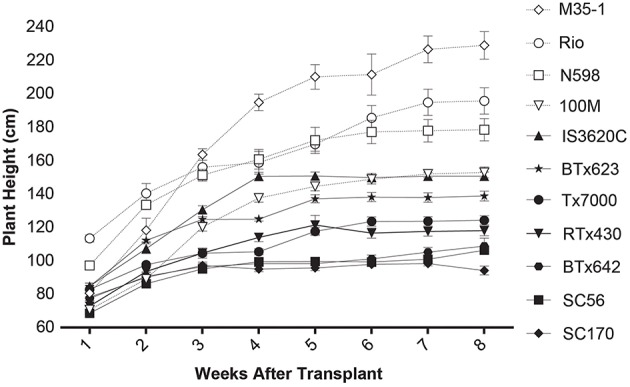
Growth of 11 sorghum lines over 8 weeks post-transplant, 12 weeks post-germination. Biomass types are shown with open symbols and dotted lines, grain types with closed symbols and solid lines.